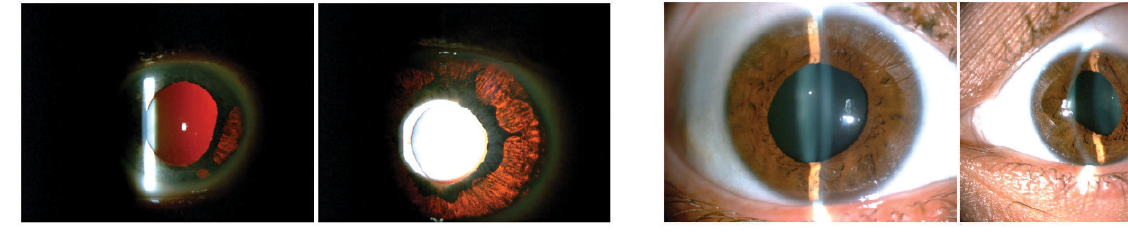
Figure 1 - Right and left eye anterior segment photograph. Positive iris transillumination.